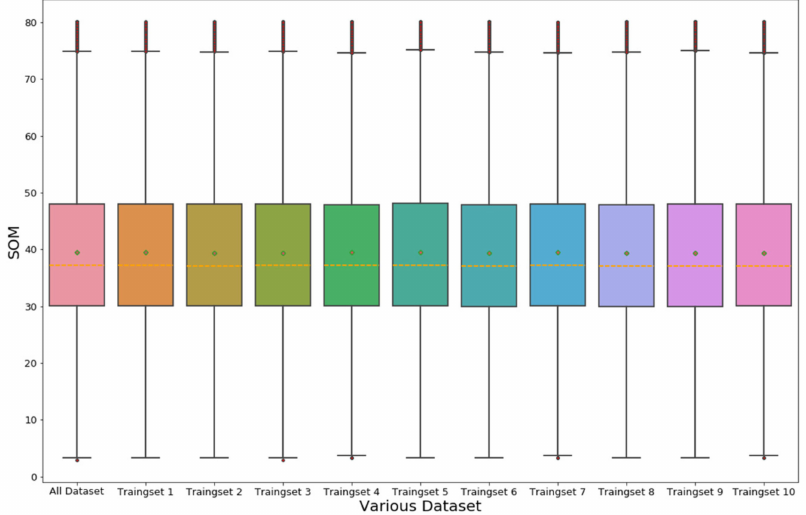
Figure 4. Boxplot of SOM of all datasets and 10 training sets with n = 100,000